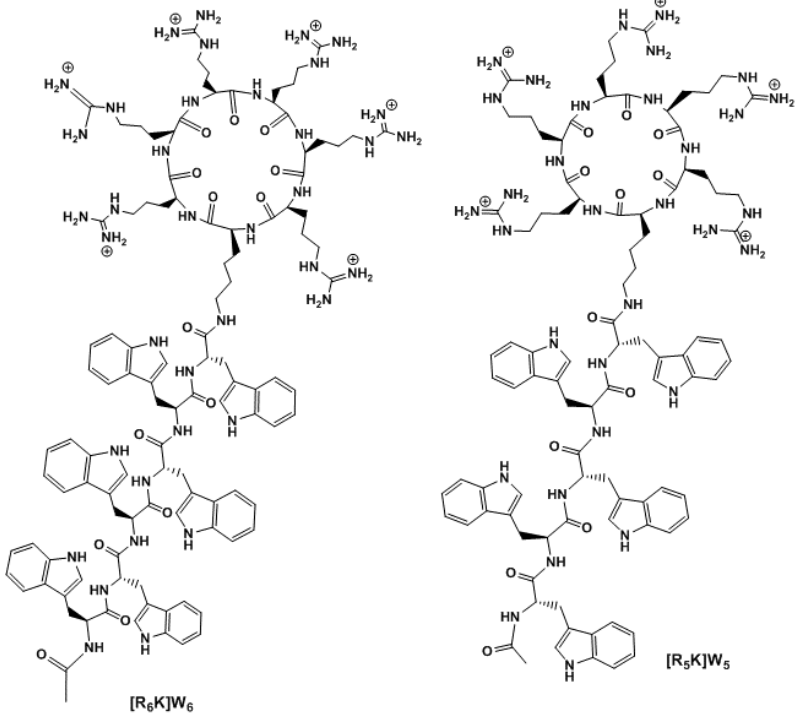
Figure 2. Peptides containing positively-charged residues on the ring attached to dydrophobic tryptophan chain.